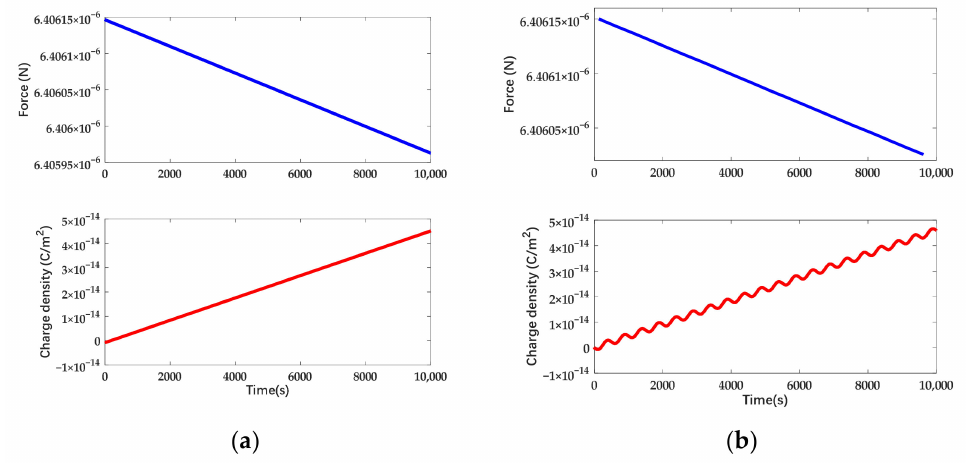
Figure 14. Charge density and electrostatic force variation in time domain while the deposited charge is increasing. The actuation voltage is symmetrically applied: ( a ) Applying DC actuation; ( b ) Applying AC actuation.